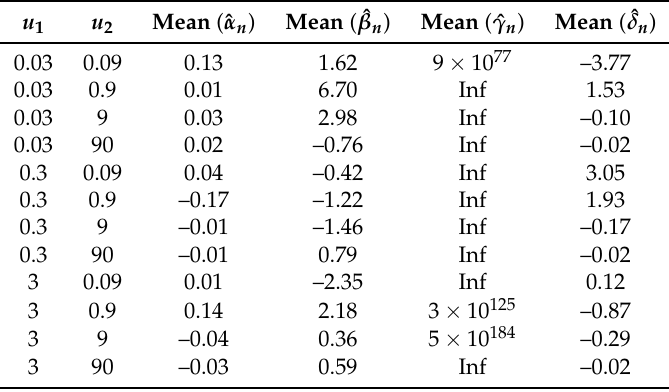
Table 5. Cumulant estimates for the data of claims ( n = 2802).